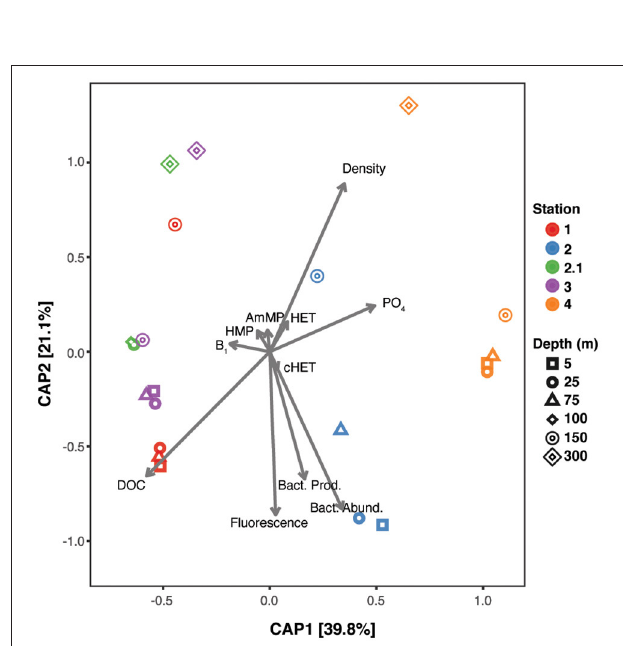
FIGURE 4 | Canonical Analysis of Principle Coordinates (CAP) of 16S rRNA ASV profiles constrained by physical and chemical environmental parameters, including TRC measurements. Ordination was constructed with the Bray–Curtis distances among samples. Shape of the points represent the depth origin of the samples and colors distinguish the station where these were collected. The axis represents the first and second constrained component and the percentages correspond to the fraction of the variance explained under the linear combination of the selected environmental parameters. Arrows show the variance direction of each environmental